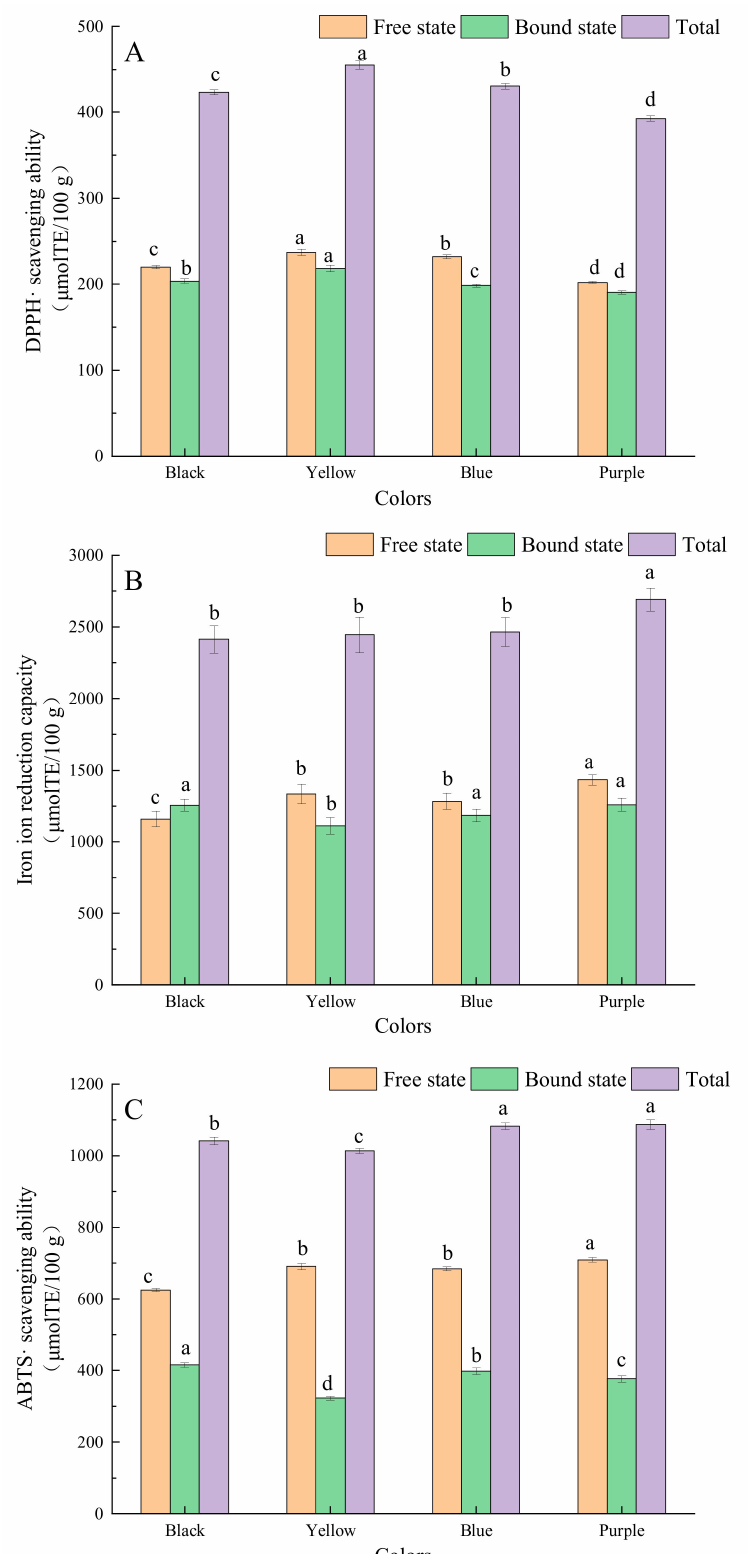
Figure 4. In vitro antioxidant capacity of phenolic fractions from barley of different colors. ( A ) DPPH · scavenging ability; ( B ) Iron ion reduction capacity; ( C ) ABTS · scavenging ability. Lower-case letters in the table indicate significant differences among different colors of barley about free state, bound state or total ( p <